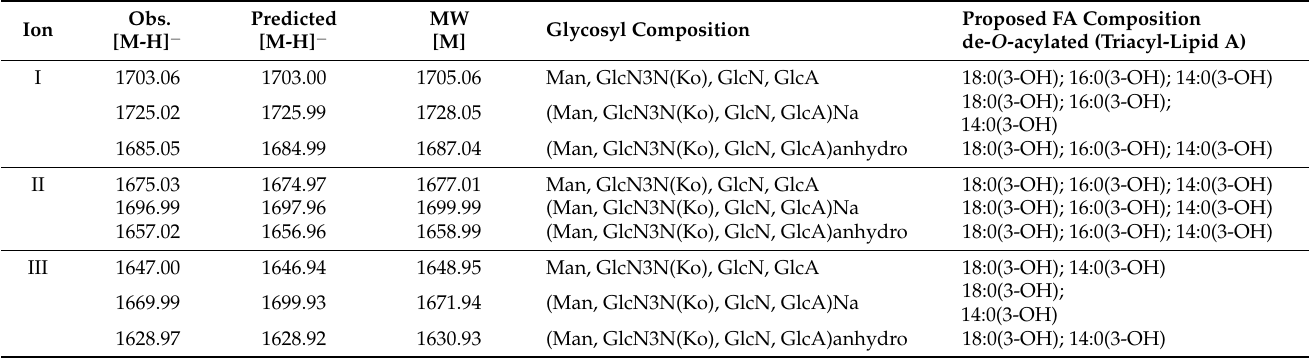
Figure 6 Figure 6. MALDI-TOF MS of de- O -acylated G. bethesdensis Ko–lipid A and the proposed acylation pattern after chemical degradation. The spectrum was acquired in a negative reflectron mode [M-H] − . For proposed compositions, refer to Table 4. Table 4. Major [M-H)] − ions observed in the MALDI-TOF MS analysis of de- O -acylated G. bethesdensis Ko–lipid A and proposed compositions (corresponding MALDI-TOF MS spectrum in Figure